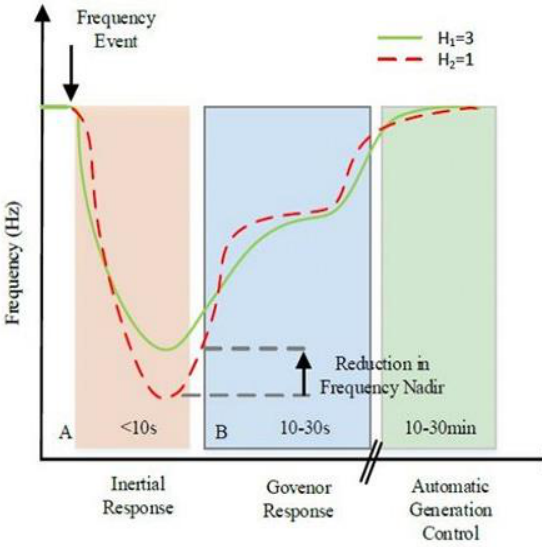
Figure 12. Frequency response obtained after the occurrence of frequency event